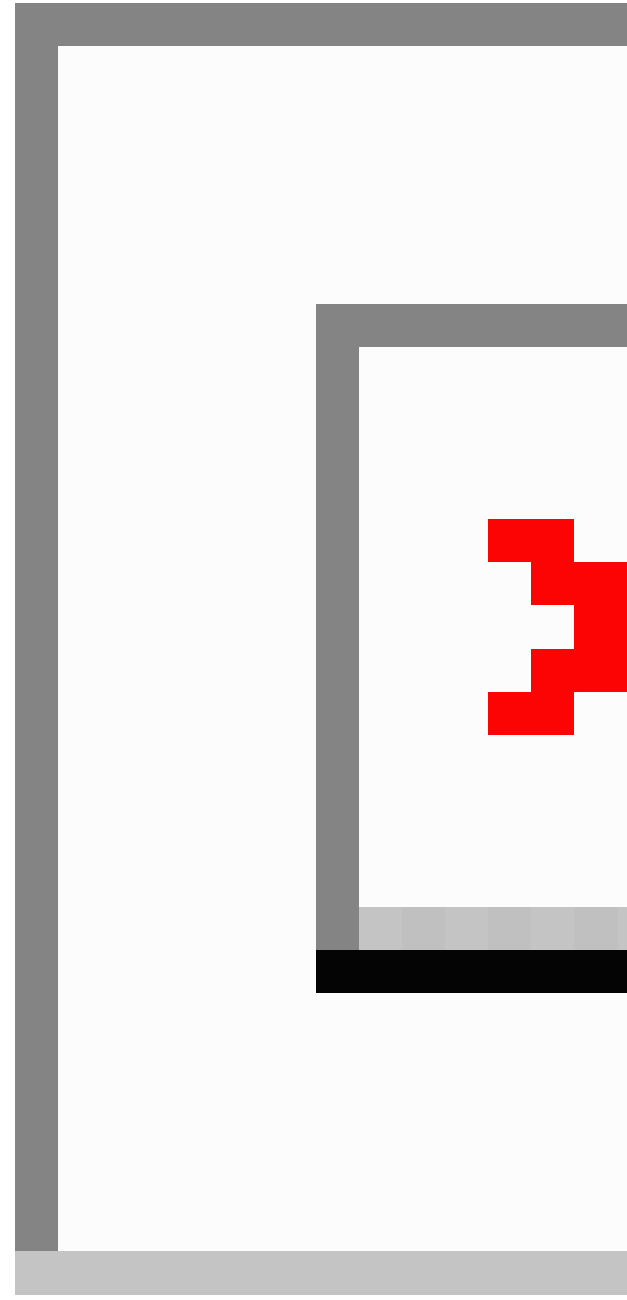
Figure 1. New GoFundMe campaigns by week versus incident COVID-19 cases by week. Percent changes of campaigns created from the previous week are shown above each